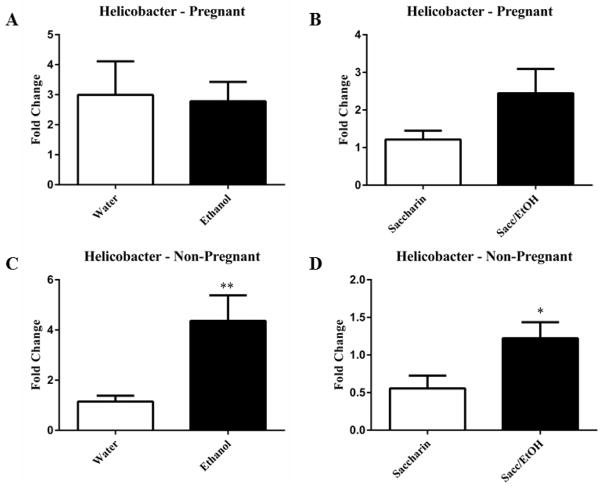
Helicobacter levels are increased in non-pregnant mice in response to ethanol consumptionEthanol in water solutions (3C) and ethanol and saccharin in water solutions (3D) significantly increased Helicobacter levels in non-pregnant animals. Ethanol and saccharin in water solutions increased Helicobacter levels in pregnant (3B) animals, but this did not reach significance. Data are expressed as mean fold change ± SEM, n=8–10 mice, t (16) = 2.76, **p=0.01 (3C) and t (15) =2.40, *p=0.03 (3D). Ethanol drinking conditions are presented in the filled columns and control (water or saccharin alone) are in the unfilled columns.